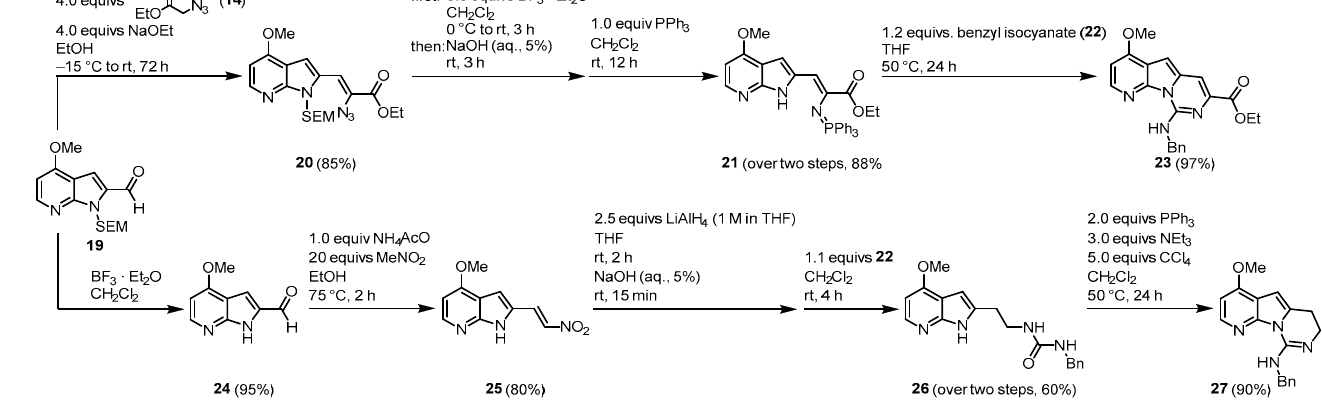
Figure 6. Two approaches to the synthesis of the tricyclic pyridopyrrolopyrimidine structures, 23 and 27 [44]. 27